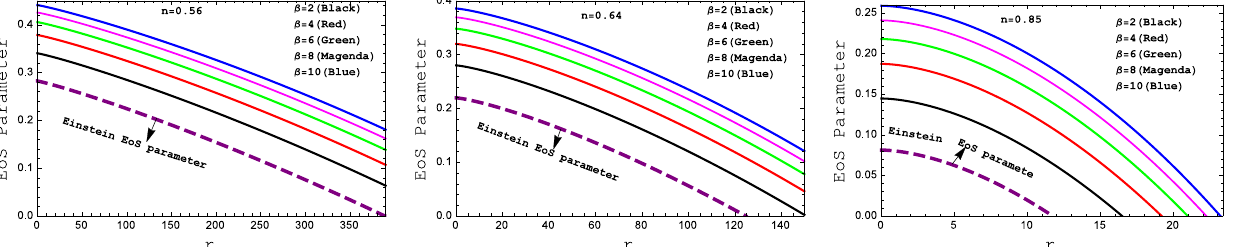
Figure 8. Behavior of the “EoS parameter” with respect to the radial coordinate “r” for the compact stars PSR J1614-2230 ( left panel ), Vela X-1 ( middle panel ) and 4U 1538-52 ( right panel ) corresponding to the numerical value of constants A and B from Table 2 and for different values of β